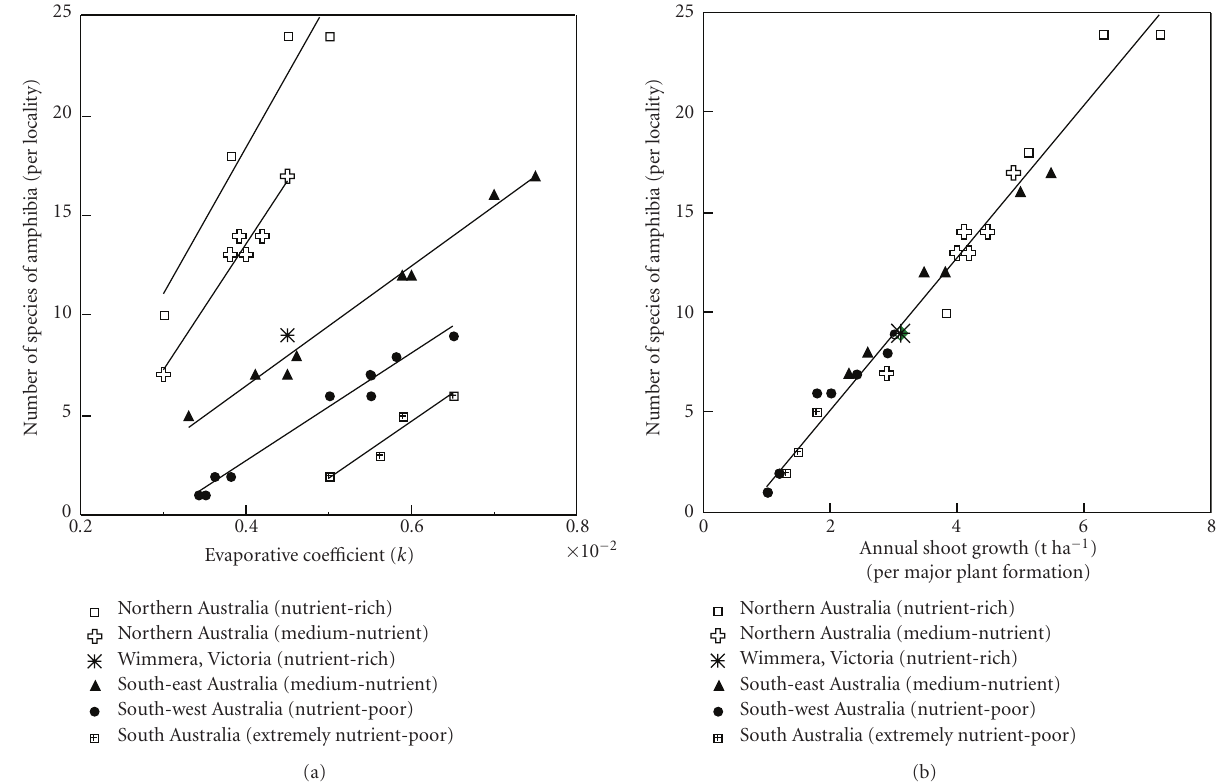
Figure 6: (a) Number ( N ) of species of Amphibians in nutrient-rich, medium-nutrient, nutrient-poor, and extremely nutrient-poor habitats in northern and southern Australia (Table 1), plotted against the Evaporative Coe ffi cient ( k ) of the sampling locality [26]. Perhumid climatic zone– k > 0 . 75 × 10 − 2 ; humid climatic zone— k = 0 . 75 − 0 . 55 × 10 − 2 ; subhumid climatic zone— k = 0 . 55 − 0 . 45 × 10 − 2 ; semiarid climatic zone— k = 0 . 45 − 0 . 35 × 10 − 2 ; arid climatic zone— k < 0 . 35 × 10 − 2 . Nutrient-rich soils (Nth Aust.): N = 0.737 k − 11.01 ( n = 4, r 2 = 0 . 93). Medium-nutrient soils (Nth Aust.): N = 0.629 k − 11.61 ( n = 6, r 2 = 0 . 94). Nutrient-rich soils (Vic.): N = 9 when k = 0 . 45 × 10 − 2 (only one site). Medium-nutrient soils (SE Aust.): N = 0.300 k − 5.59 ( n = 8, r 2 = 0 . 98). Nutrient-poor soils (SW Aust.): N = 0.267 k − 7.99 ( n =